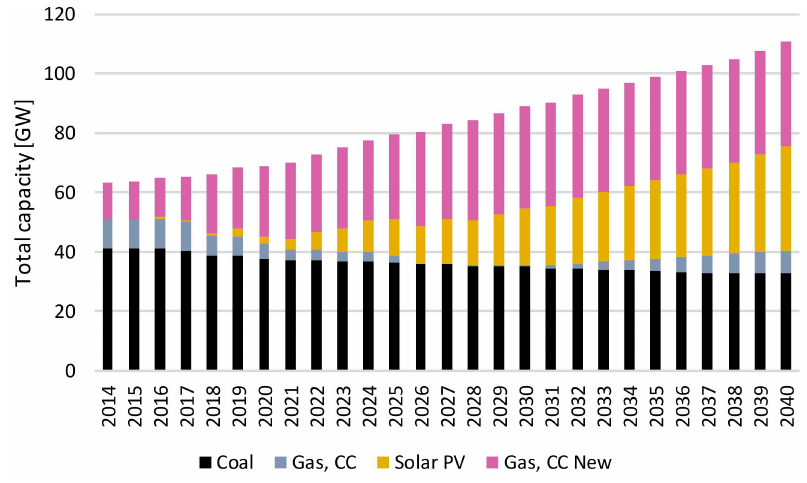
Figure 17. Total capacity (GW) in the REF scenario, in cases of higher gas prices—with code modifications.